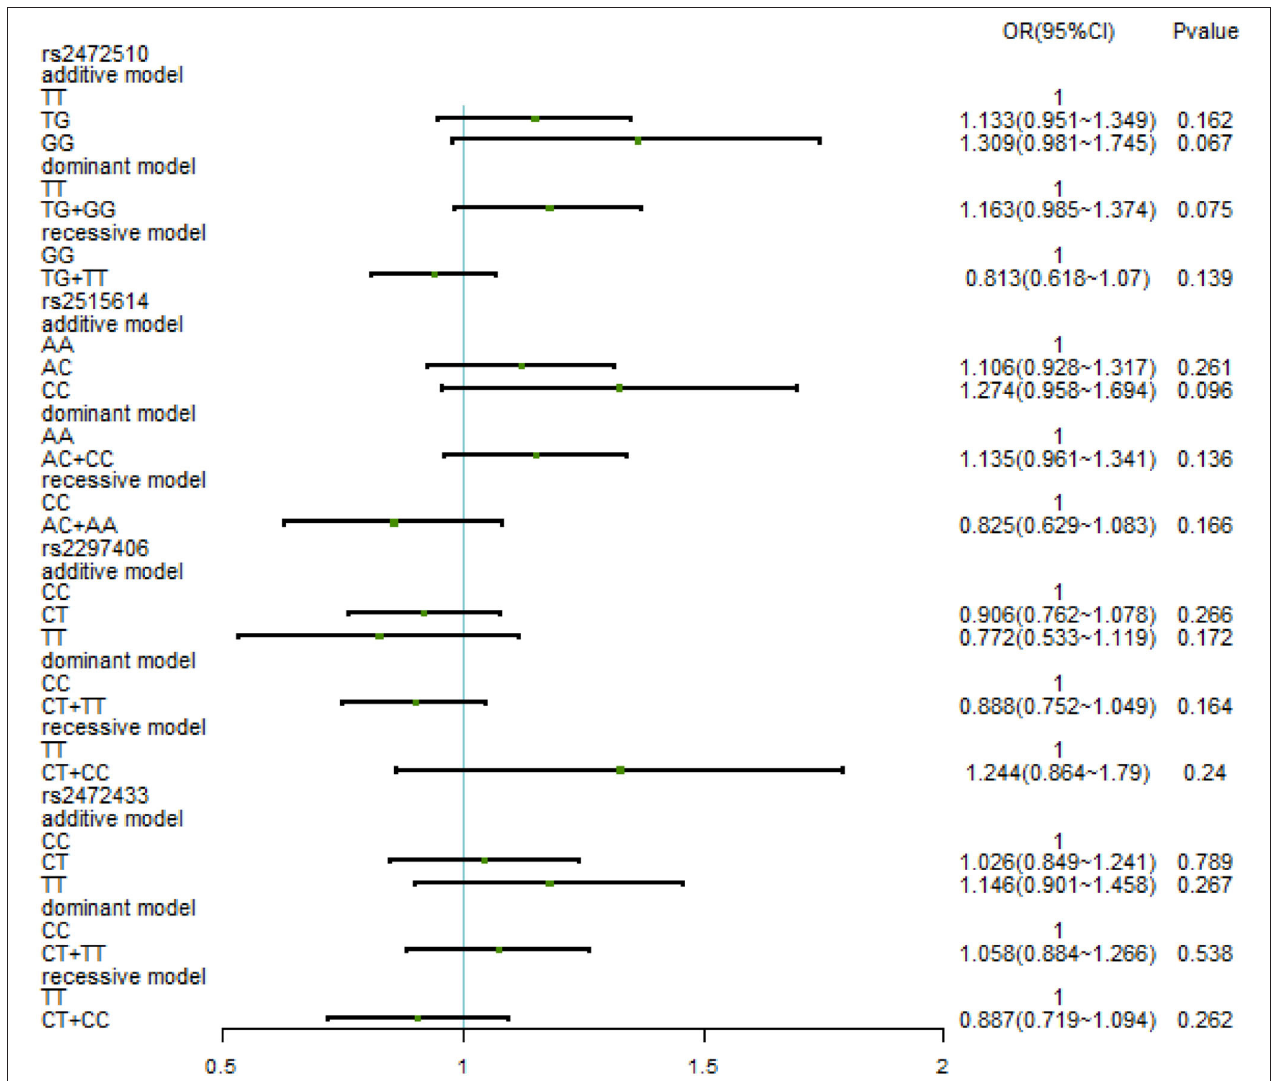
FIGURE 1 | Binary logistic regression analysis for the association between genotypes of rs2472510, rs2515614, rs2297406, rs2472433, and high